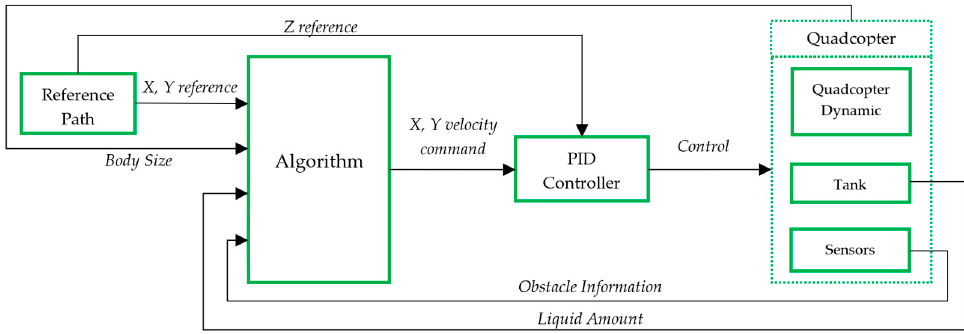
Figure 3. Operation drone control architecture.